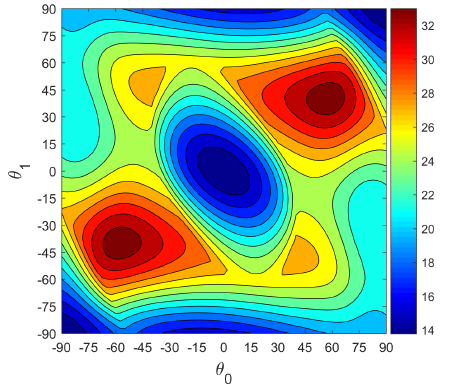
Figure 5. Critical temperatures for Graphite/Epoxy, SSSS variable-stiffness plates with lay-up [ ± < θ | θ > x ] s . Results obtained using ED3 0 1